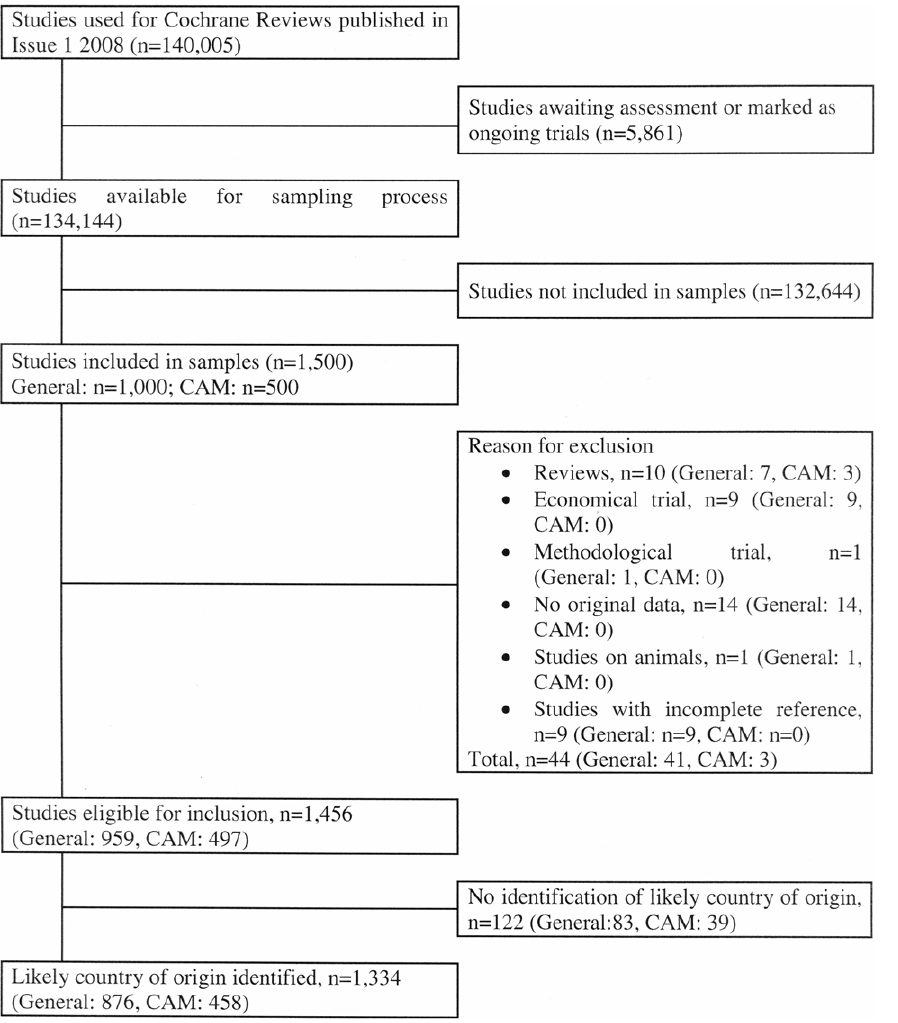
Figure 1. Flow diagram according to the QUOROM-statement [ 27 ] with the total number of studies used for Cochrane Reviews and the number included in the present study. CAM=Complementary and alternative medicine.